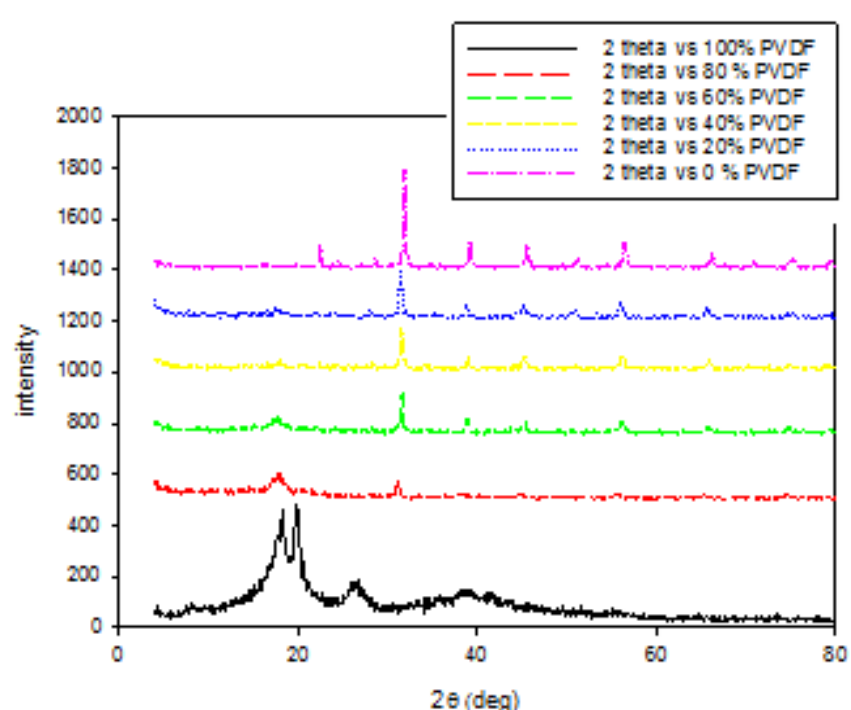
Figure 3. The XRD patterns of the prepared (BZT-PVDF) composite.